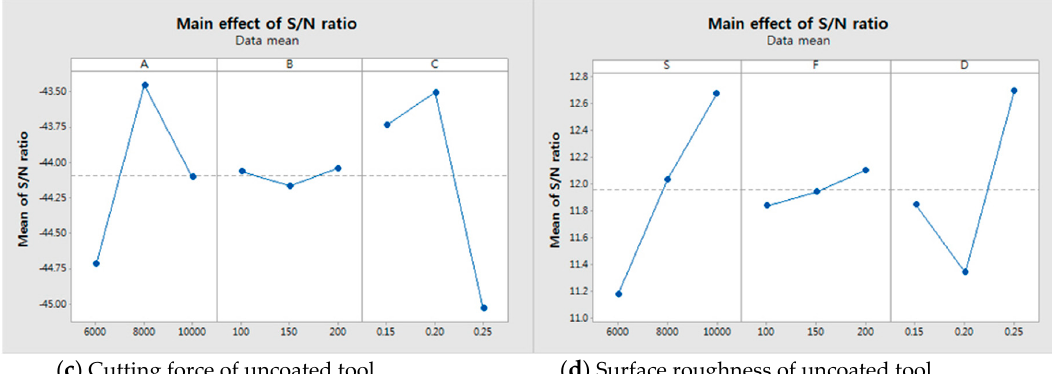
Figure 6. The main effect plot of the coated and uncoated tools on the cutting force and the surface roughness. ( a ) Cutting force of coated tool; ( b ) Surface roughness of coated tool; ( c ) Cutting force of uncoated tool; ( d ) Surface roughness of uncoated tool.